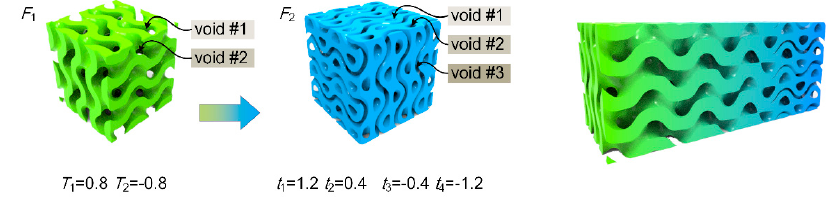
Figure 3. Generation of multi-sheet structure by transition between structures to generate branched